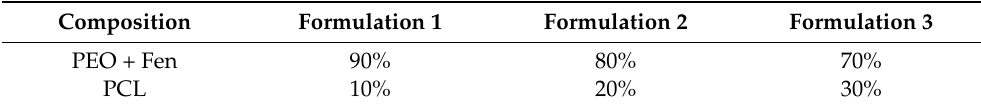
Table 1. Description of the formulations’ composition.